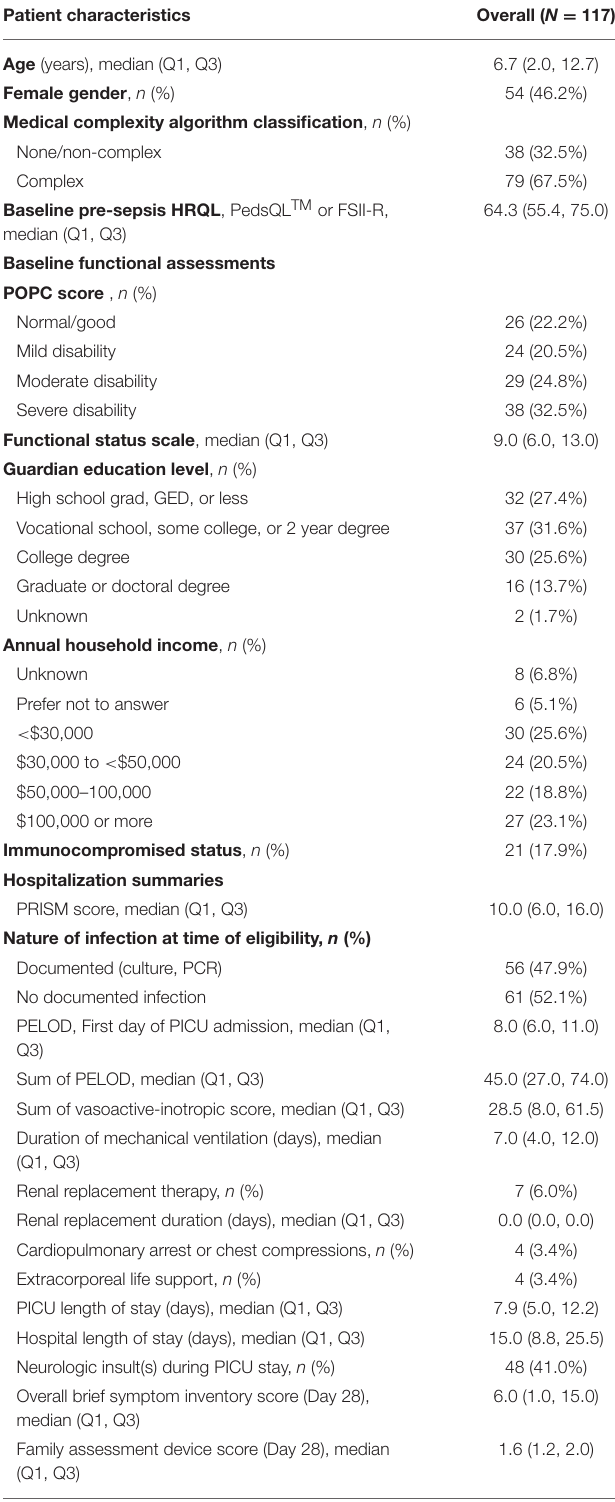
TABLE 1 | Patient and hospitalization characteristics at